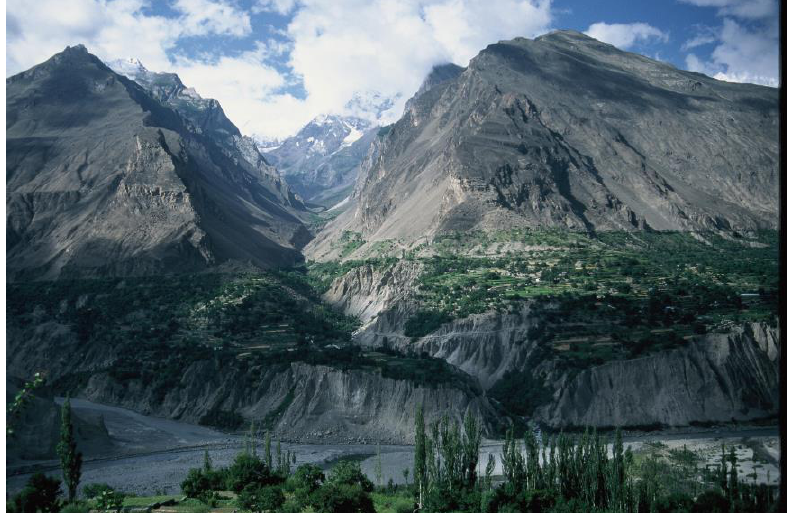
Figure 2. A view of Hunza River’s canyon in 2001.